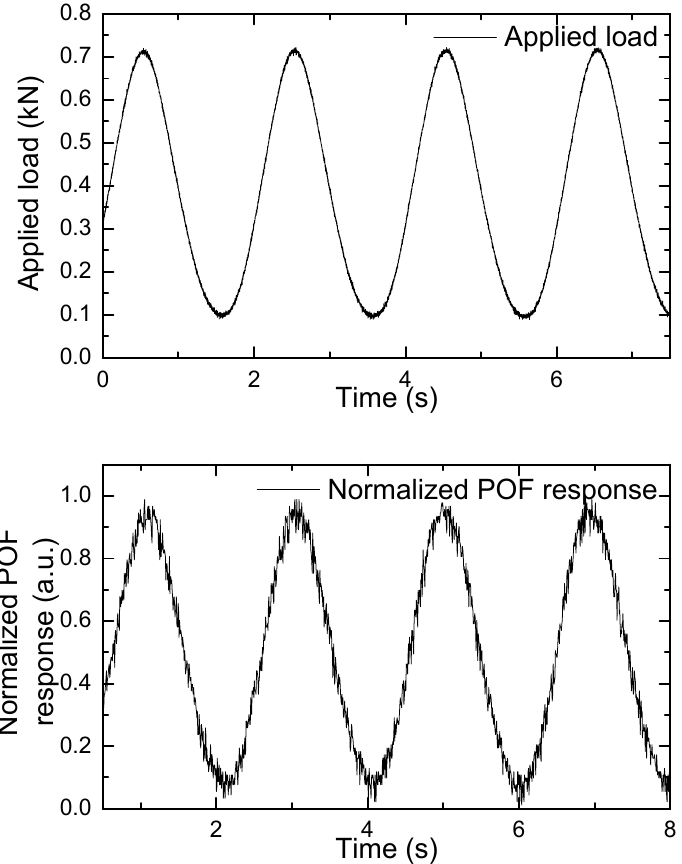
Figure 10. Applied load and normalized POF response that simulate a walking pattern.